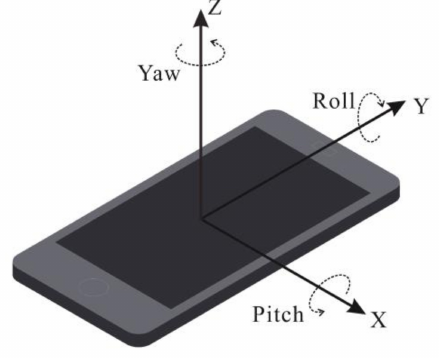
Figure 3. Smartphone reference